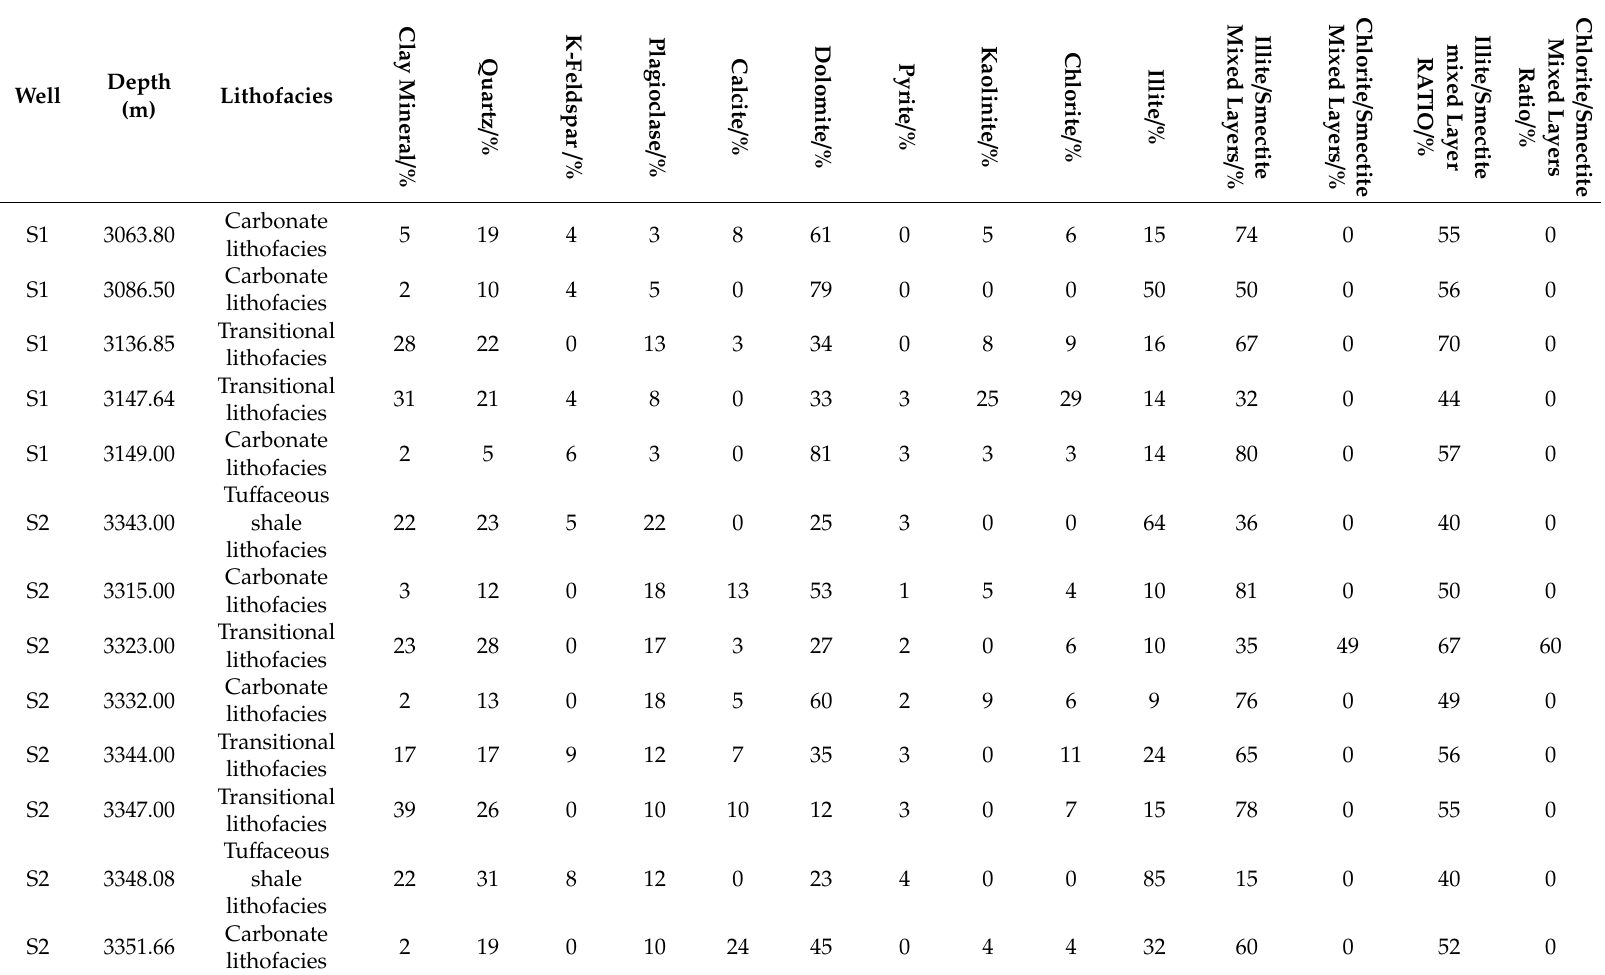
Table 1. Test data table of mineral composition of di ff erent lithofacies samples in the Luchaogou